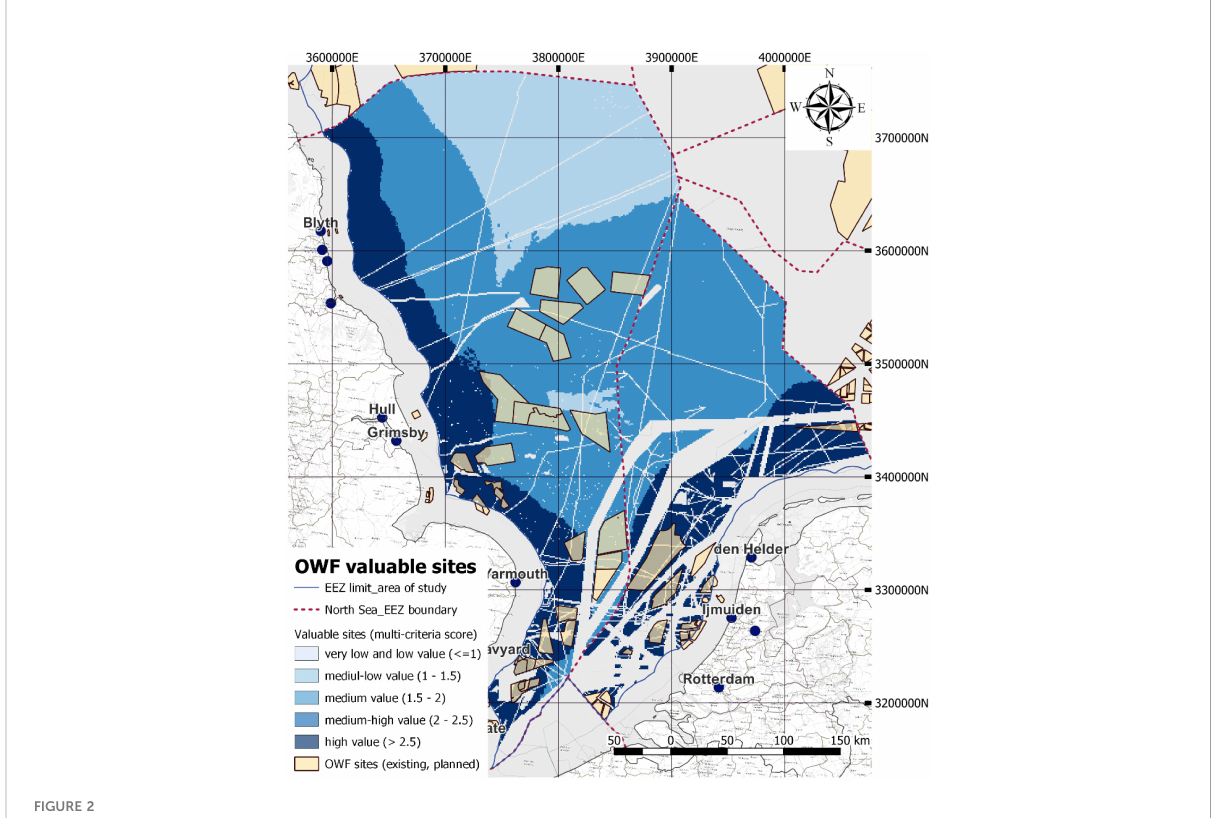
FIGURE 2 Valuable OWF sites in the Dutch and English